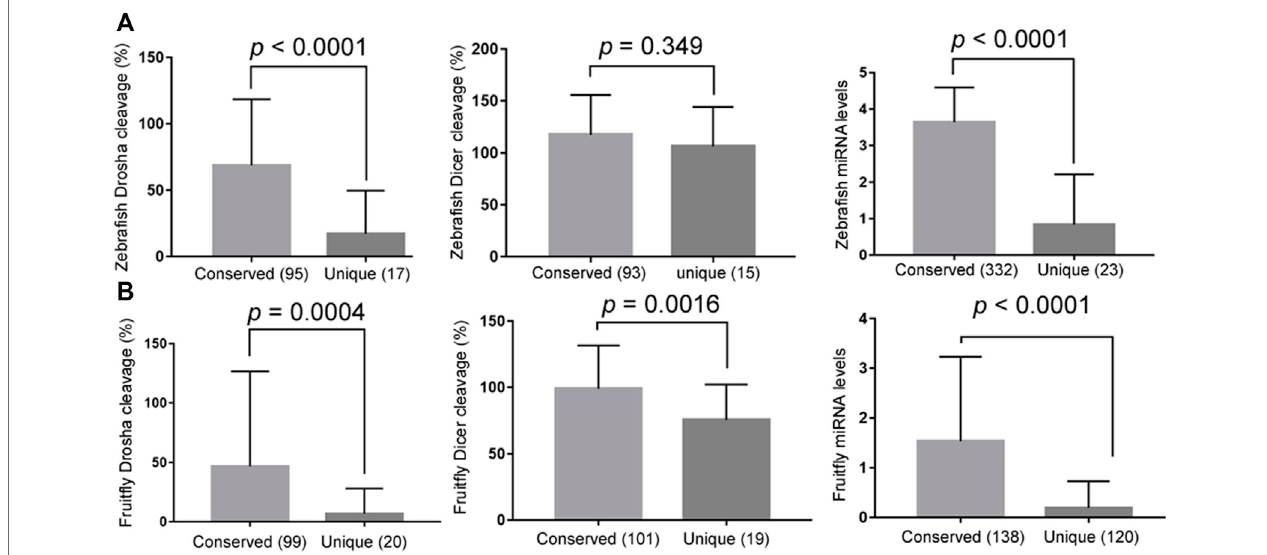
FIGURE 4 | Conserved miRNAs are more ef fi ciently processed and better expressed. (A) Comparing the relative Drosha cleavage ef fi ciencies (the left panel) , Dicer cleavage ef fi ciencies (the middle panel) , and mature miRNA expression (the right panel) between the conserved and unique zebra fi sh miRNAs (x-axes). The right panel analyzed all the miRNAs, i.e., not just the Drosha or Dicer substrates examined in this study, and the y-axis is miRNA expression values after log 10 transformation (GSE57169). Averages and standard deviations are shown, the P values listed on top, and parentheses indicate the numbers of miRNAs in the